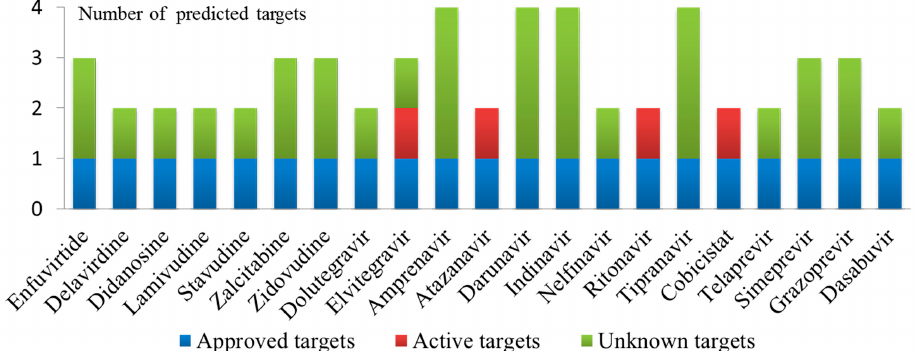
Figure 6. Number of predicted targets and known targets of 17 approved HIV-1 drugs and four approved HCV drugs (Approved targets: predicted targets are approved drug targets for drugs that are their inhibitor; Active targets: predicted targets for drugs with validated bioactivity; Unknown targets: predicted targets for drugs without validated bioactivity).